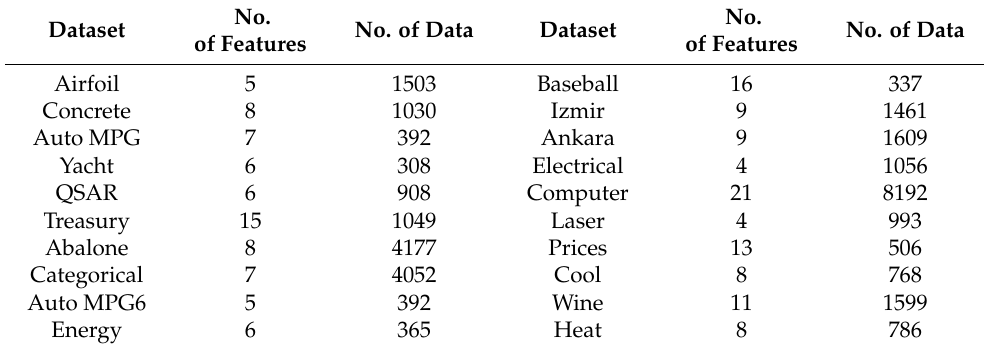
Table 3. Details of 20 regression datasets from UCI and KEEL.